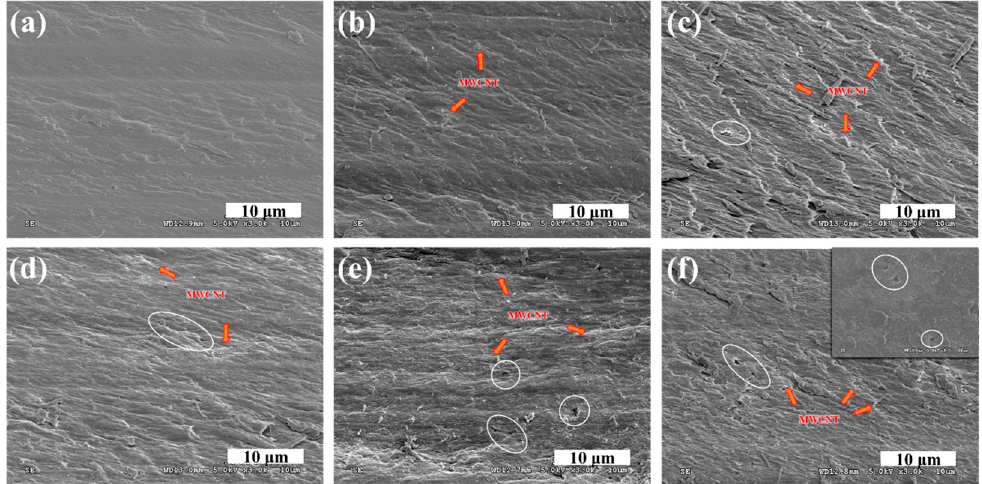
Figure 5. Cross-sectional SEM images of N-MWCNT membranes with different MWCNT weight ratios: ( a ) 0.0 wt%, ( b ) 0.2 wt%, ( c ) 0.4 wt%, ( d ) 0.6 wt%, ( e ) 0.8 wt%, and ( f ) 1.0 wt%.